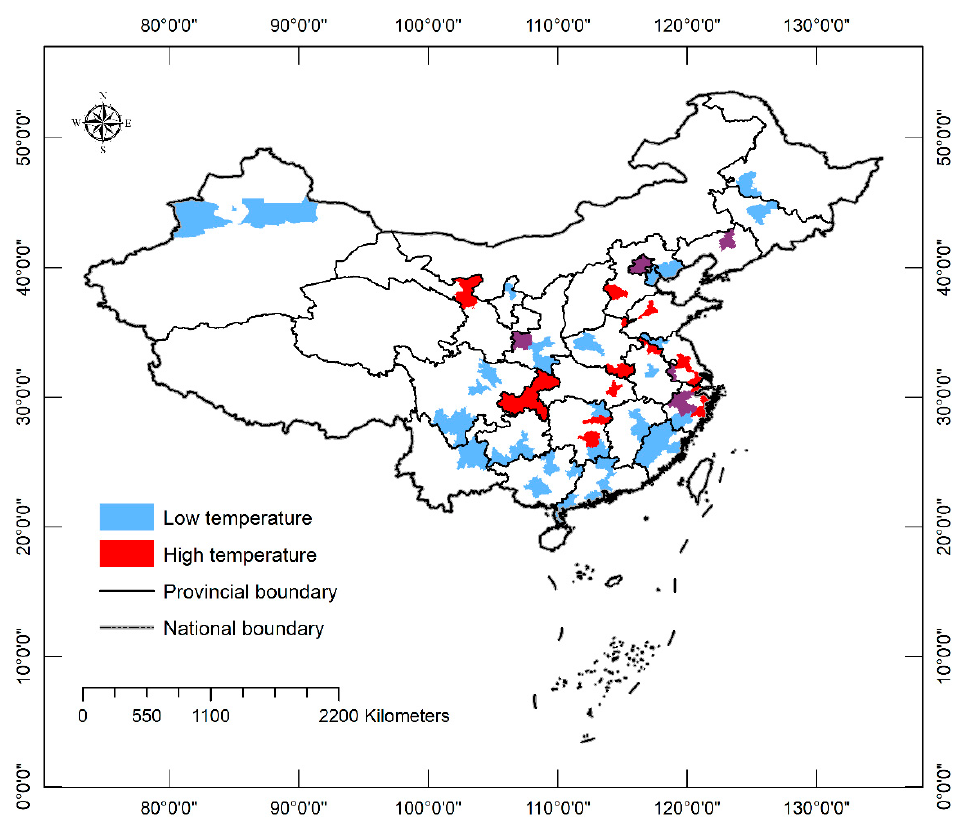
Figure 1. Spatial patterns of damages on urban trees caused by low and high temperatures in China. Cities that reported both types of damages appear as purple color due to the overlap.